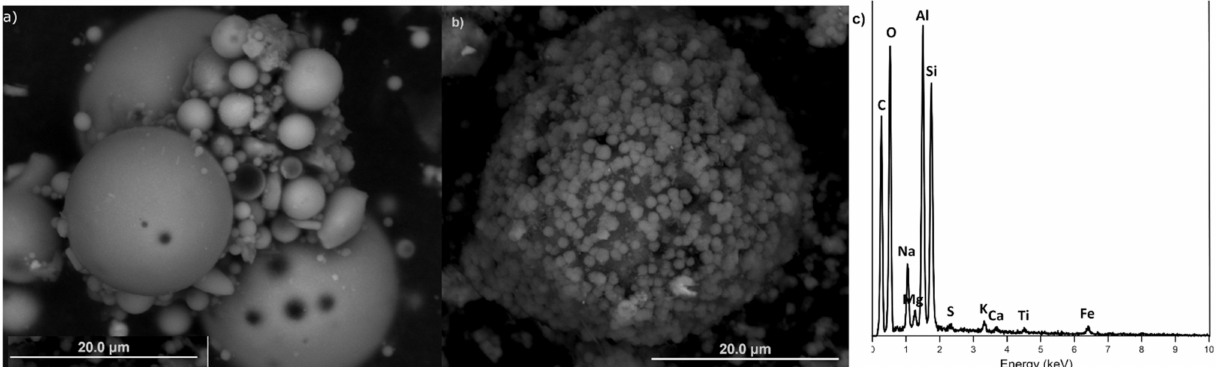
Figure 6. SEM images of ( a ) raw CFA and ( b ) zeolite SZ, ( c ) SEM-EDS results for SZ.4.3. Multi-element sorption